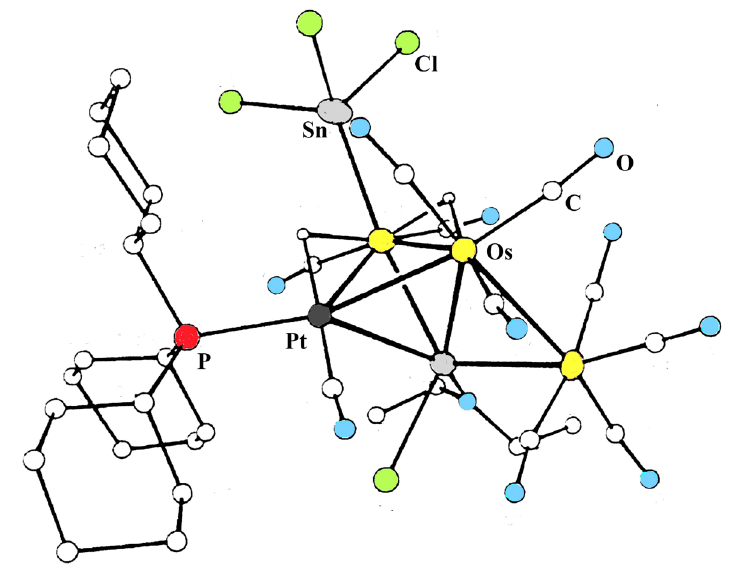
Figure 9. Structure of [(Pcy